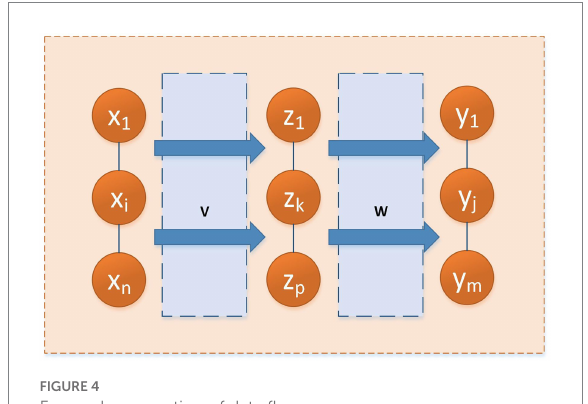
FIGURE 4 Forward propagation of data